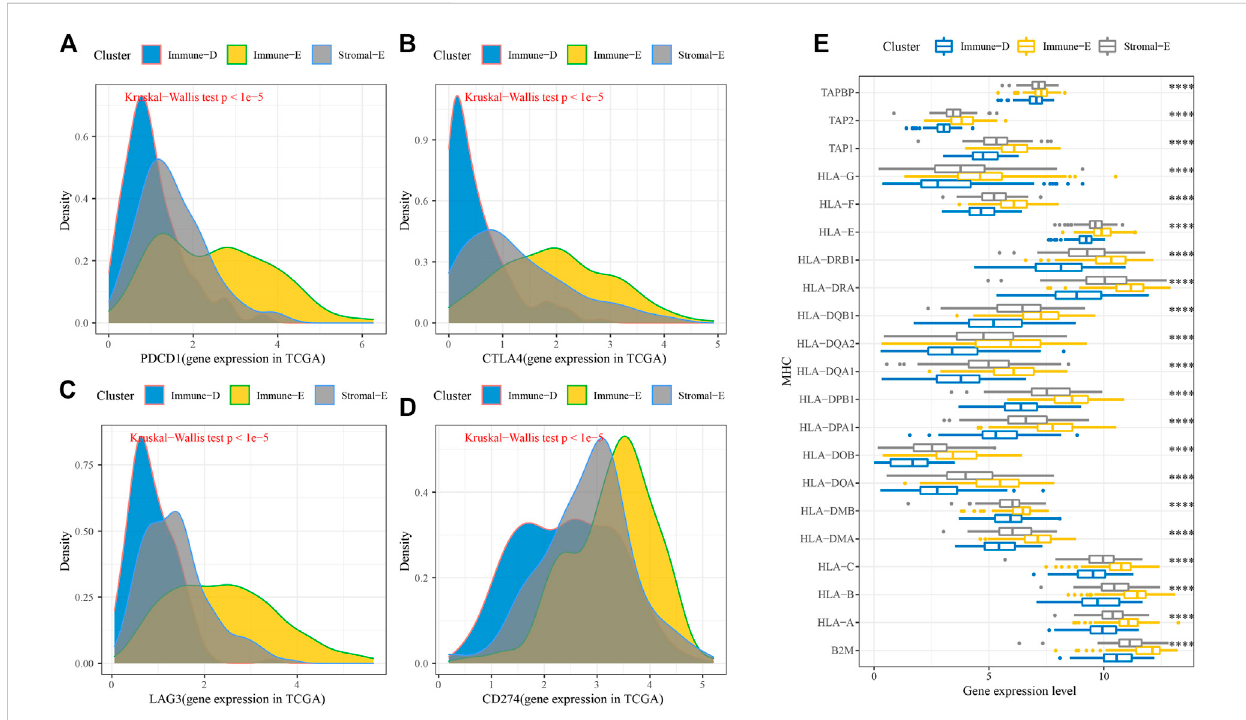
FIGURE 3 Immune checkpoint genes among the three molecular subtypes. (A) Differences in PDCD1 expression among the three molecular subtypes. (B) Differences in CTLA4 expression among the three molecular subtypes. (C) Differences in LAG3 expression among the three molecular subtypes. (D) Differences in CD274 expression among the three molecular subtypes. (E) Differences in MHC-related gene expression among the three molecular subtypes. **** p <